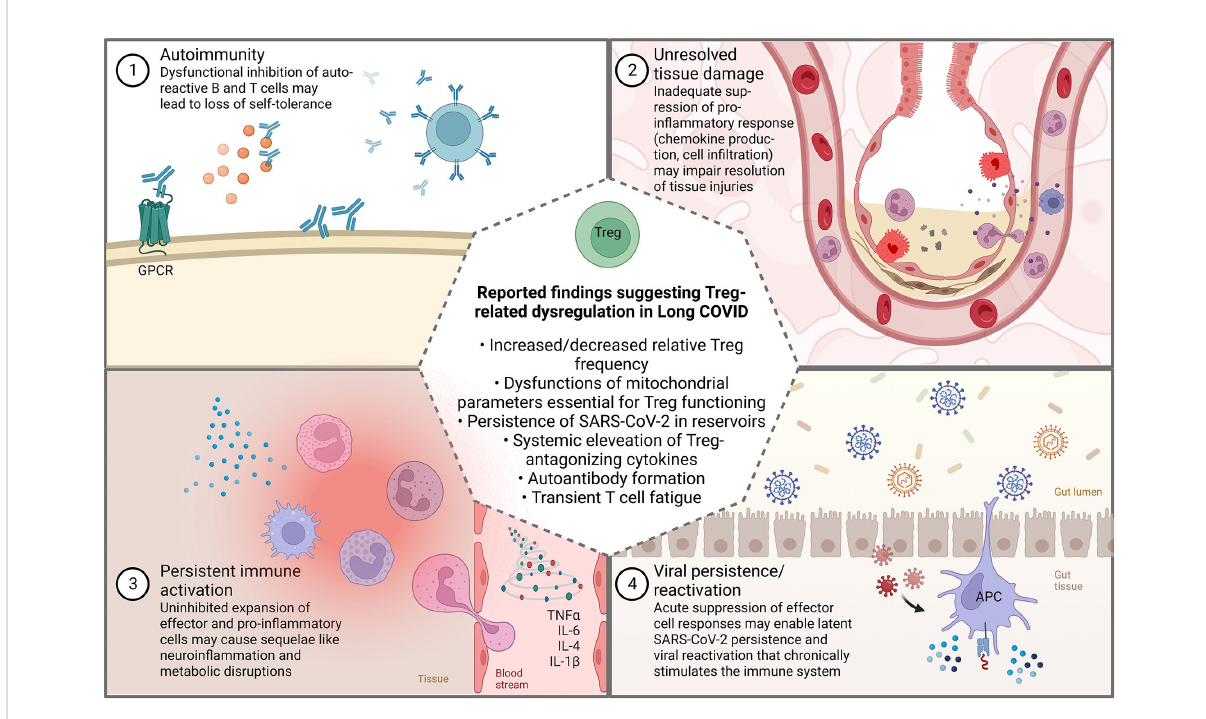
FIGURE 4 Commonly suggested theories for the non-exclusive pathophysiological mechanisms involved in Long COVID (1 – 4) and how they might be related to Treg dysregulation (created with BioRender.com). GPCR, G-protein coupled receptor